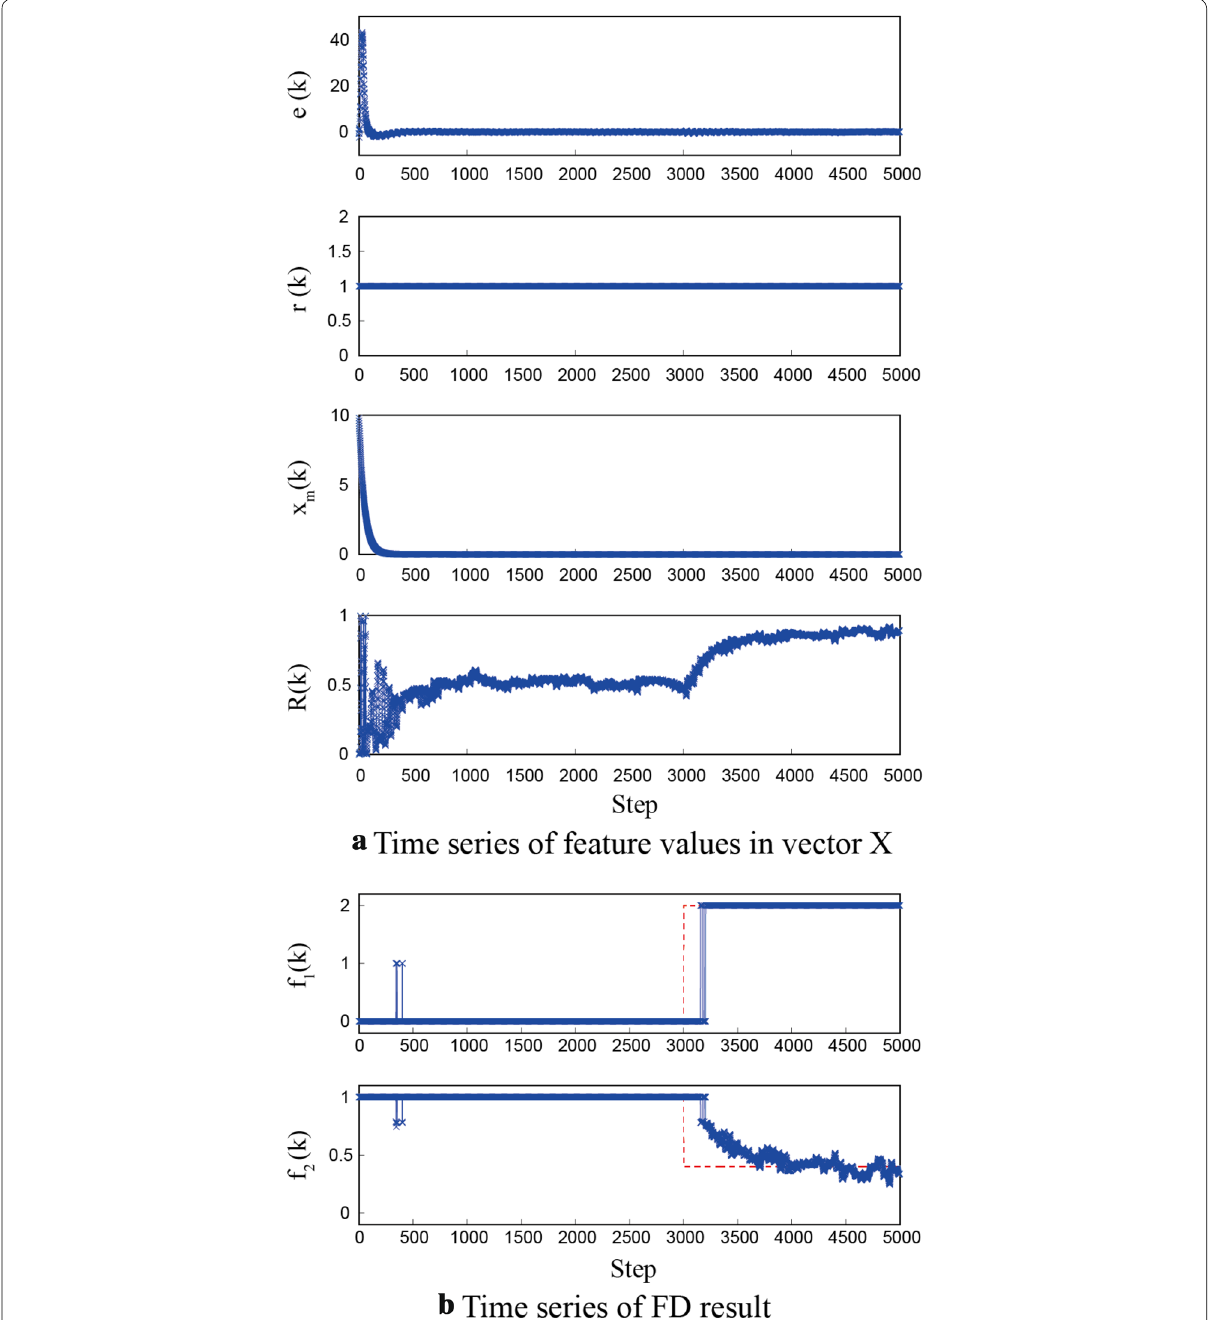
Fig. 15 Feature values and FD results in the case where the second actuator has a partial LOE ( (cid:31) 2 = 0.4 ) after 3000